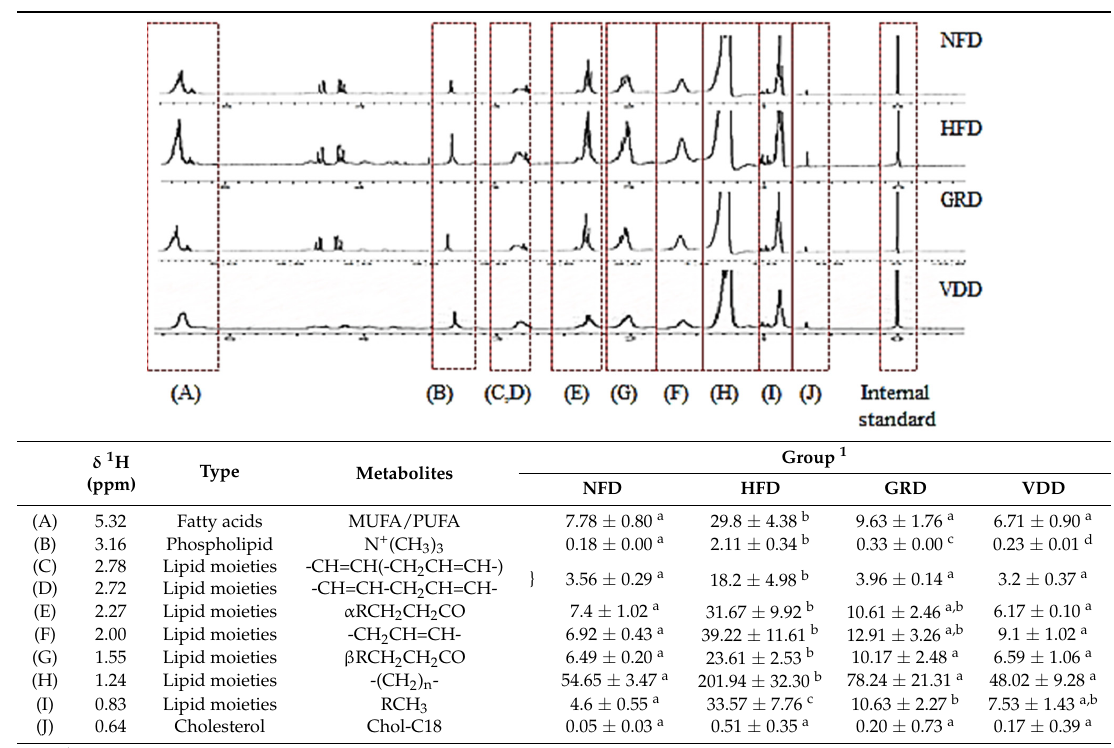
Table 5. 1 H NMR chemical shifts for endogenous lipid-soluble hepatic